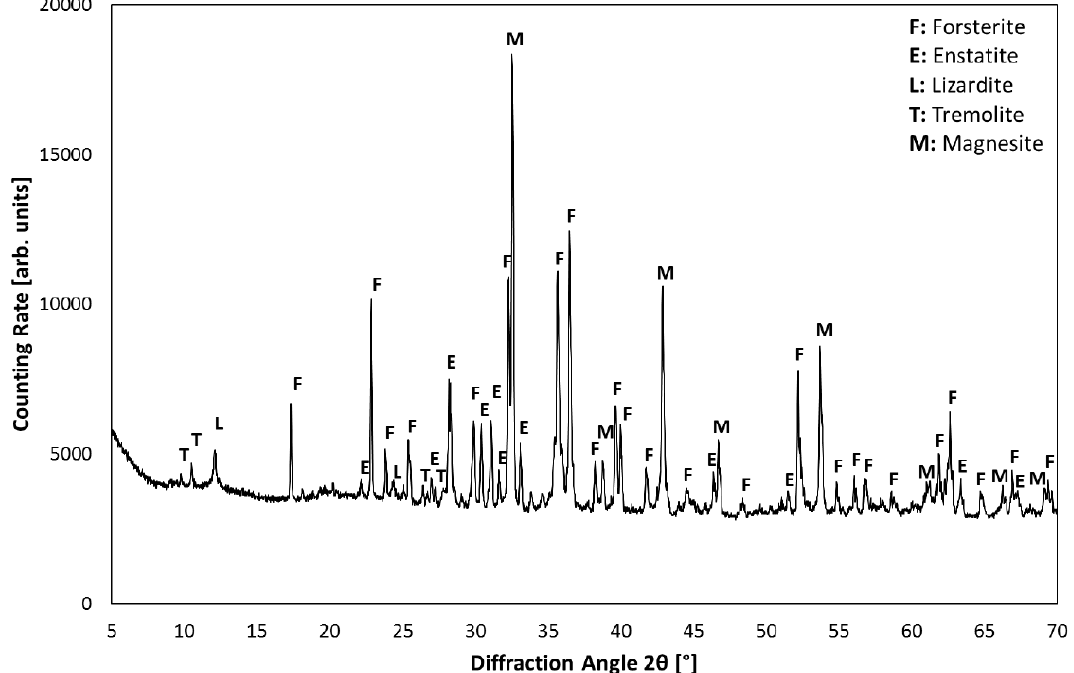
Figure 8. XRD analysis of olivine sample after carbonation.